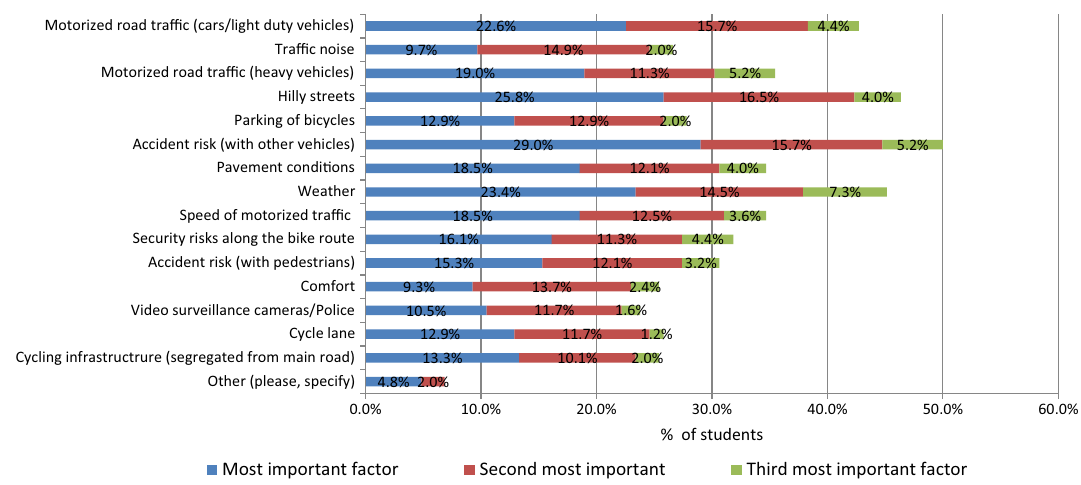
Fig. 2 Top-3 most important barriers (as perceived by school students) for not cycling to school